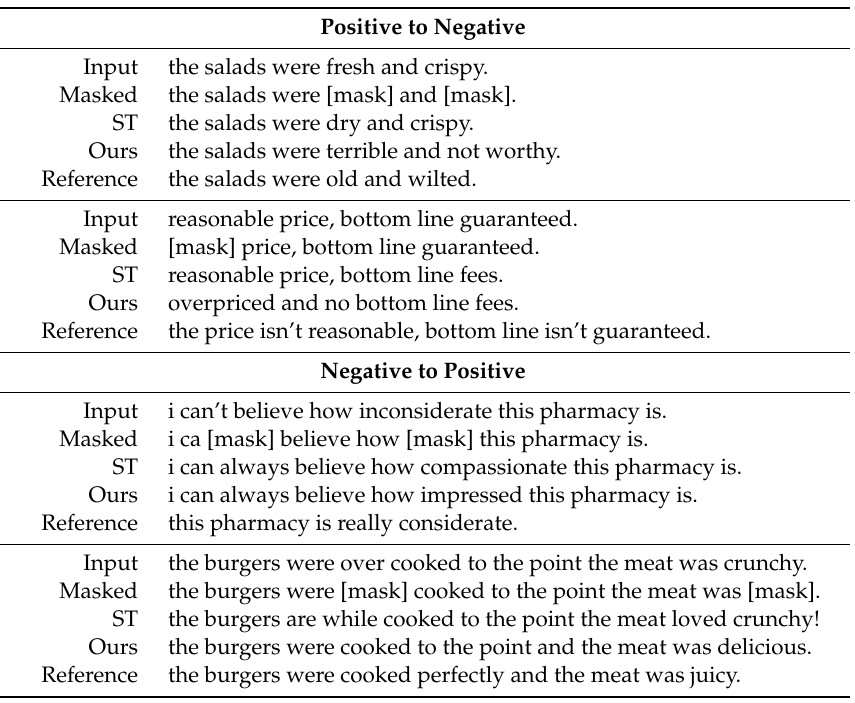
Table 4. Case studies from the Yelp